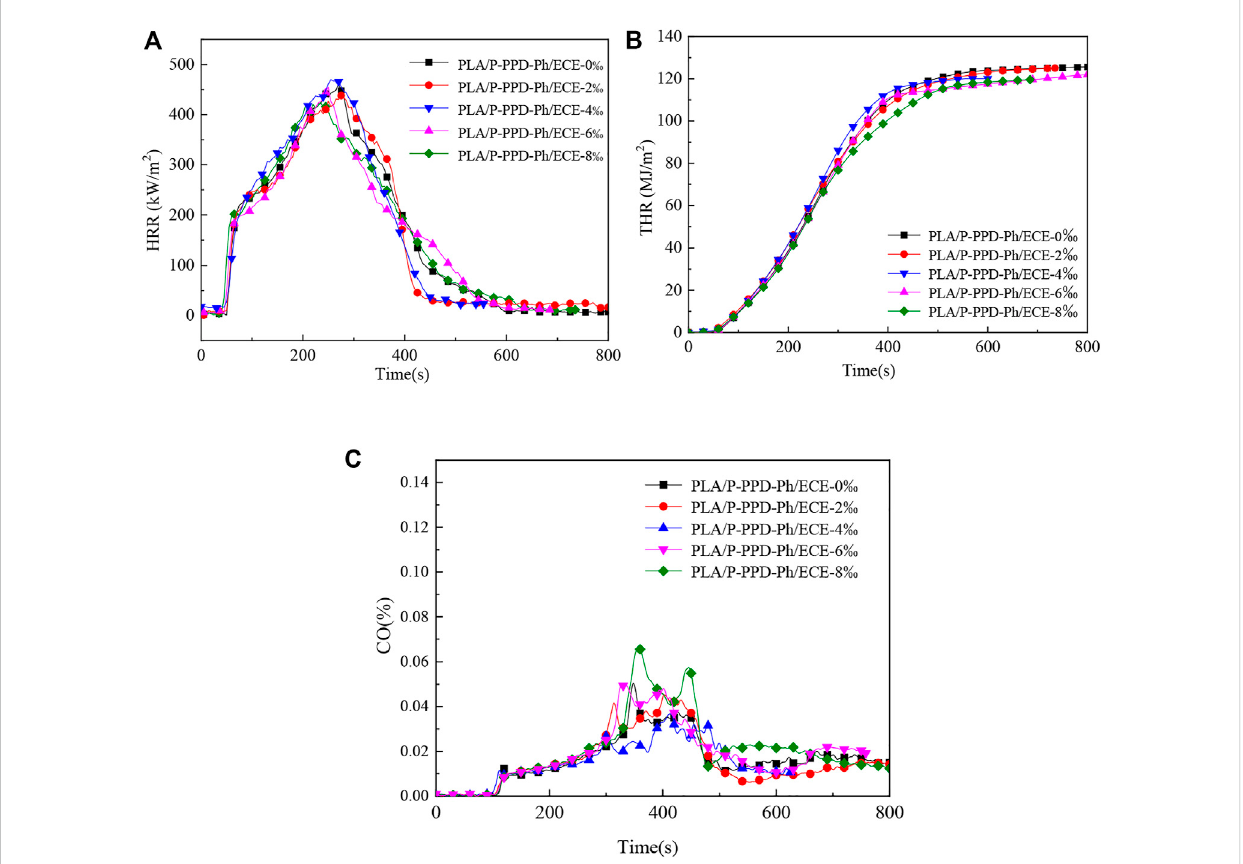
Cone calorimeter test curves for PLA/P-PPD-Ph/ECE conjugated fl ame retardant composites, (A) HRRcurve, (B) THR curve, (C) CO release curve.